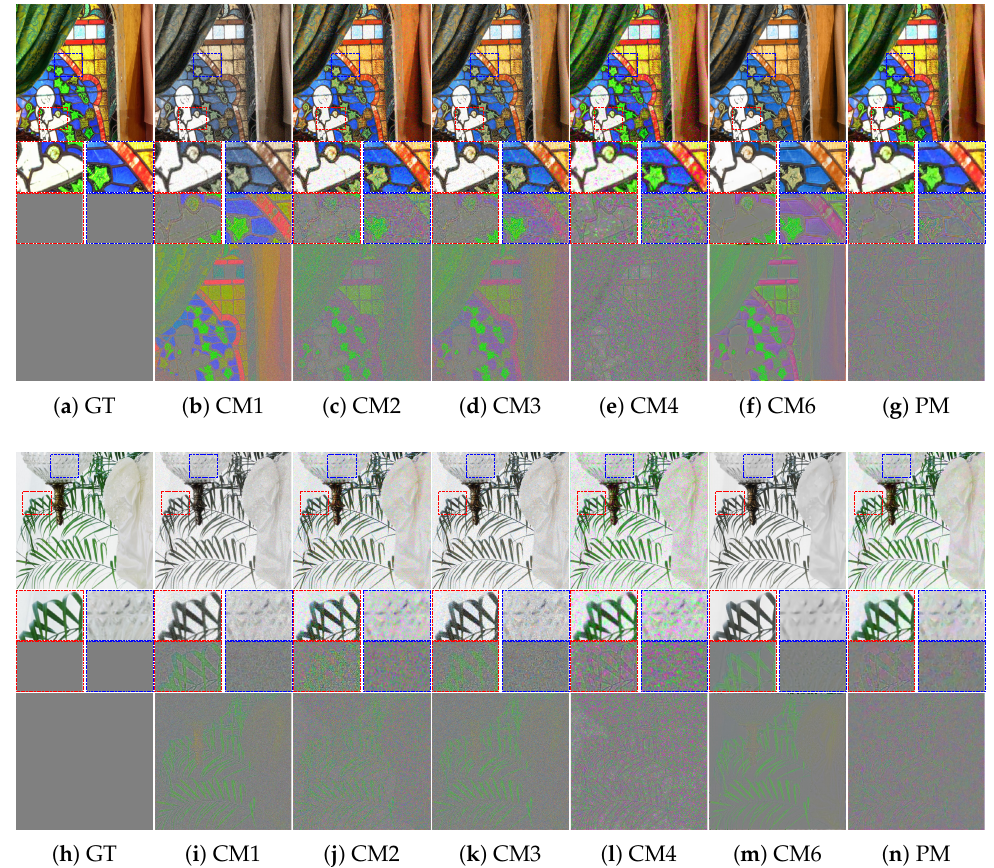
Figure 8. Visual comparison of restored images, enlarged parts, and difference maps from crosstalk degradation 2 (crosstalk kernel with σ g = 0.6 and noise with σ n = 0.04): ( a ) Ground truth, ( b ) CM1, ( c ) CM2, ( d ) CM3, ( e ) CM4, ( f ) CM6, and ( g ) PM. ( h – n ) Same methods as in ( a – g ). The first and second rows present the results of mcm1 and mcm4 in the McMaster dataset, respectively.